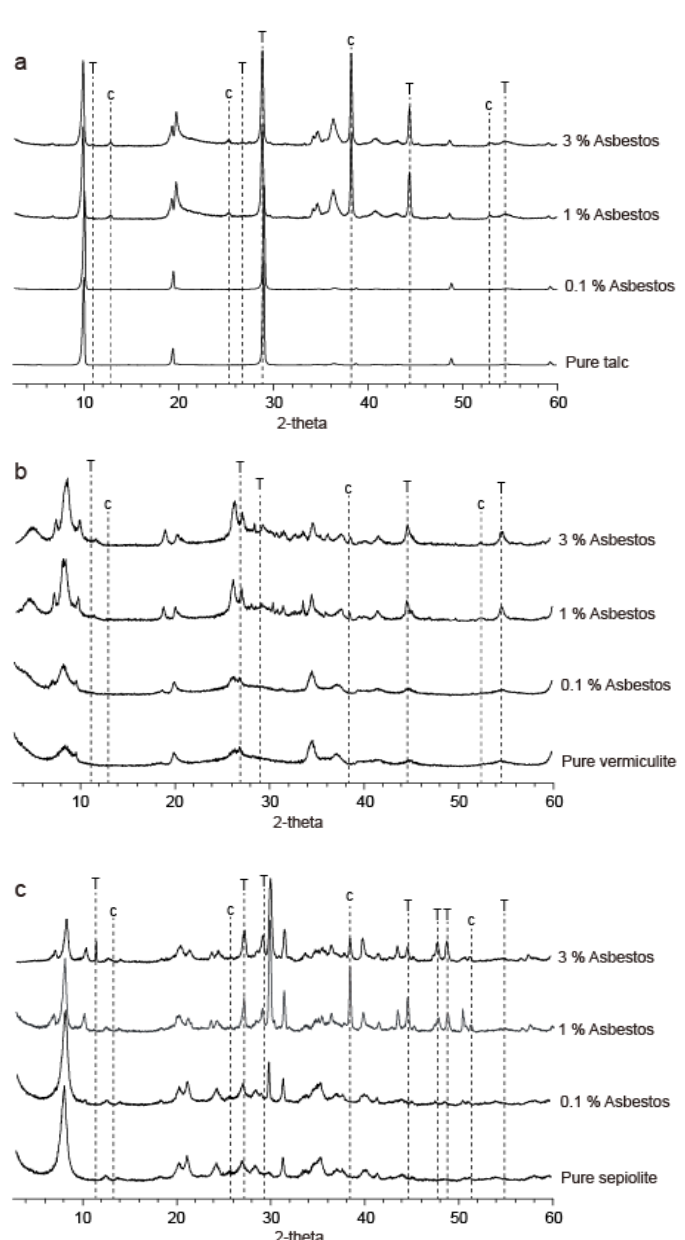
Figure 1. X-ray di ff raction patterns of standard asbestos-containing materials (ACMs): ( a ) talc, Figure 1. X-ray diffraction patterns of standard asbestos-containing materials (ACMs): ( a ) talc, ( b ) ( b ) vermiculite, and ( c ) sepiolite with di ff erent concentrations of asbestos (0%, 0.1%, 1%, and 3%). vermiculite, and ( c ) sepiolite with different concentrations of asbestos (0%, 0.1%, 1%, and 3%). T T represents asbestiform tremolite; C represents represents asbestiform tremolite; C represents chrysotile.